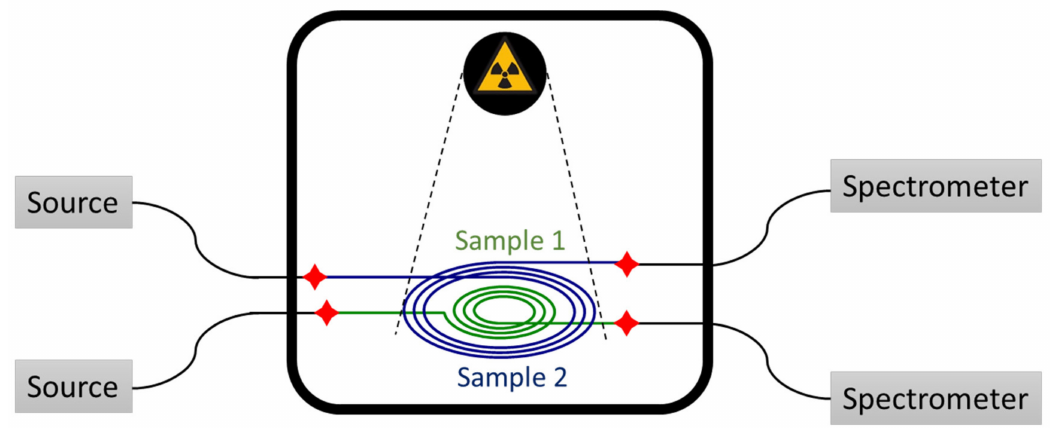
Figure 3. Experimental setup for radiation induced attenuation (RIA) measurements at the MOPERIX X-ray facility. The black continuous lines represent the rad-hardened fibers used to transport the